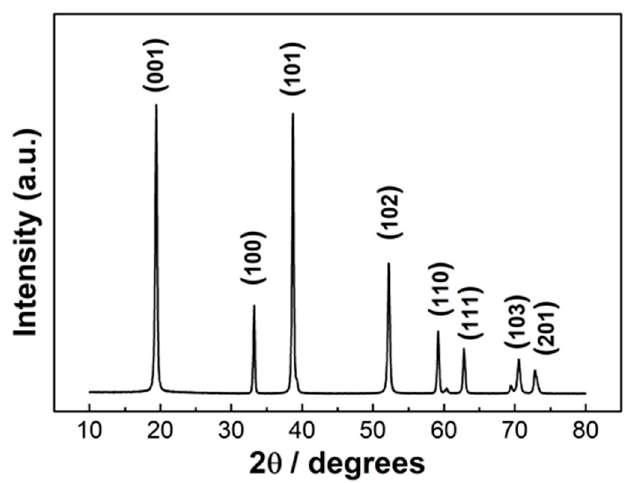
Figure 1. XRD pattern of β -Ni(OH) 2 , obtained by hydrothermal synthesis with urea.